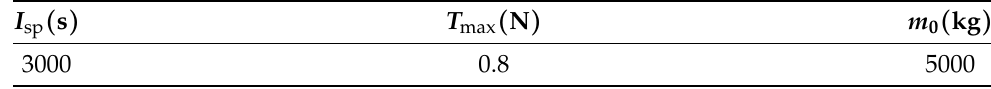
Table 6. Spacecraft performance parameters.